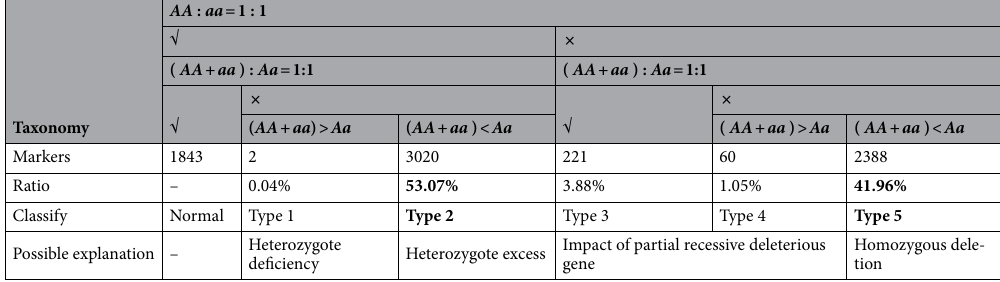
Table 3. Five classifications of zygotic selection